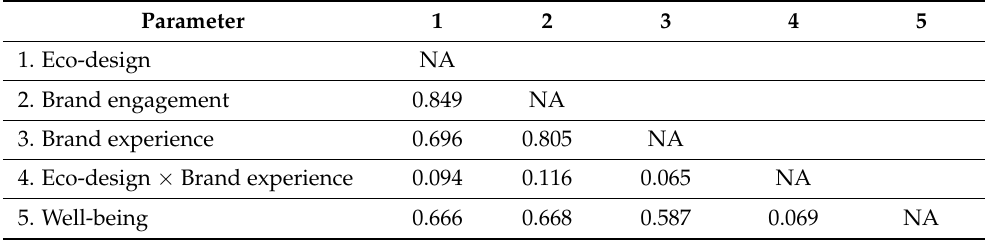
Table 4. Outcomes of the heterotrait–monotrait (HTMT) ratio of correlations.